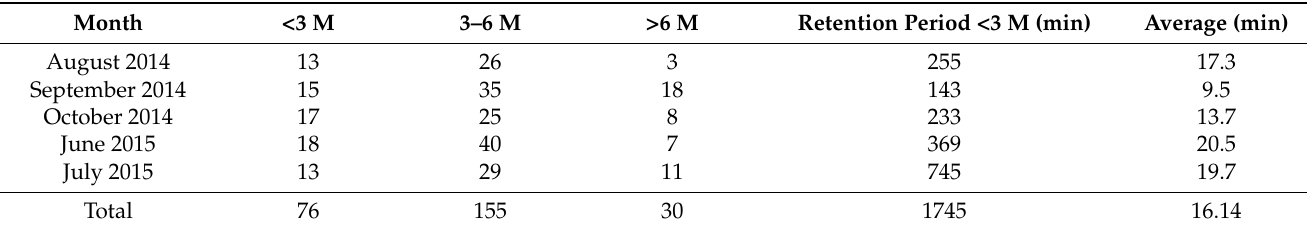
Table A3. Svetac island—density, distance and retention period of cruise ships’ traffic in selected high-risk navigational and environmental region.